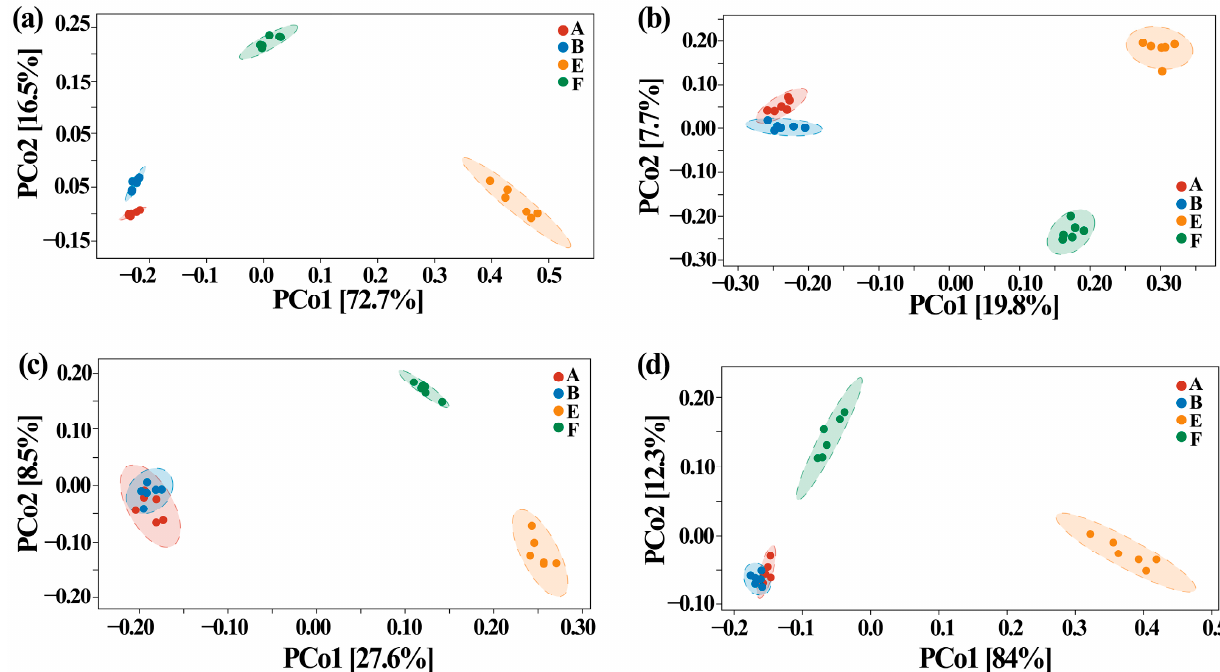
Figure 5. Effect of ZnONP on beta diversity of gut bacteria by PCoA of ( a ) Bray–Curtis, ( b ) Jaccard, ( c ) unweighted UniFrac and ( d ) weighted UniFrac. A: healthy children; B: healthy children + ZnONP; E: ASD children; F: ASD children + ZnONP.